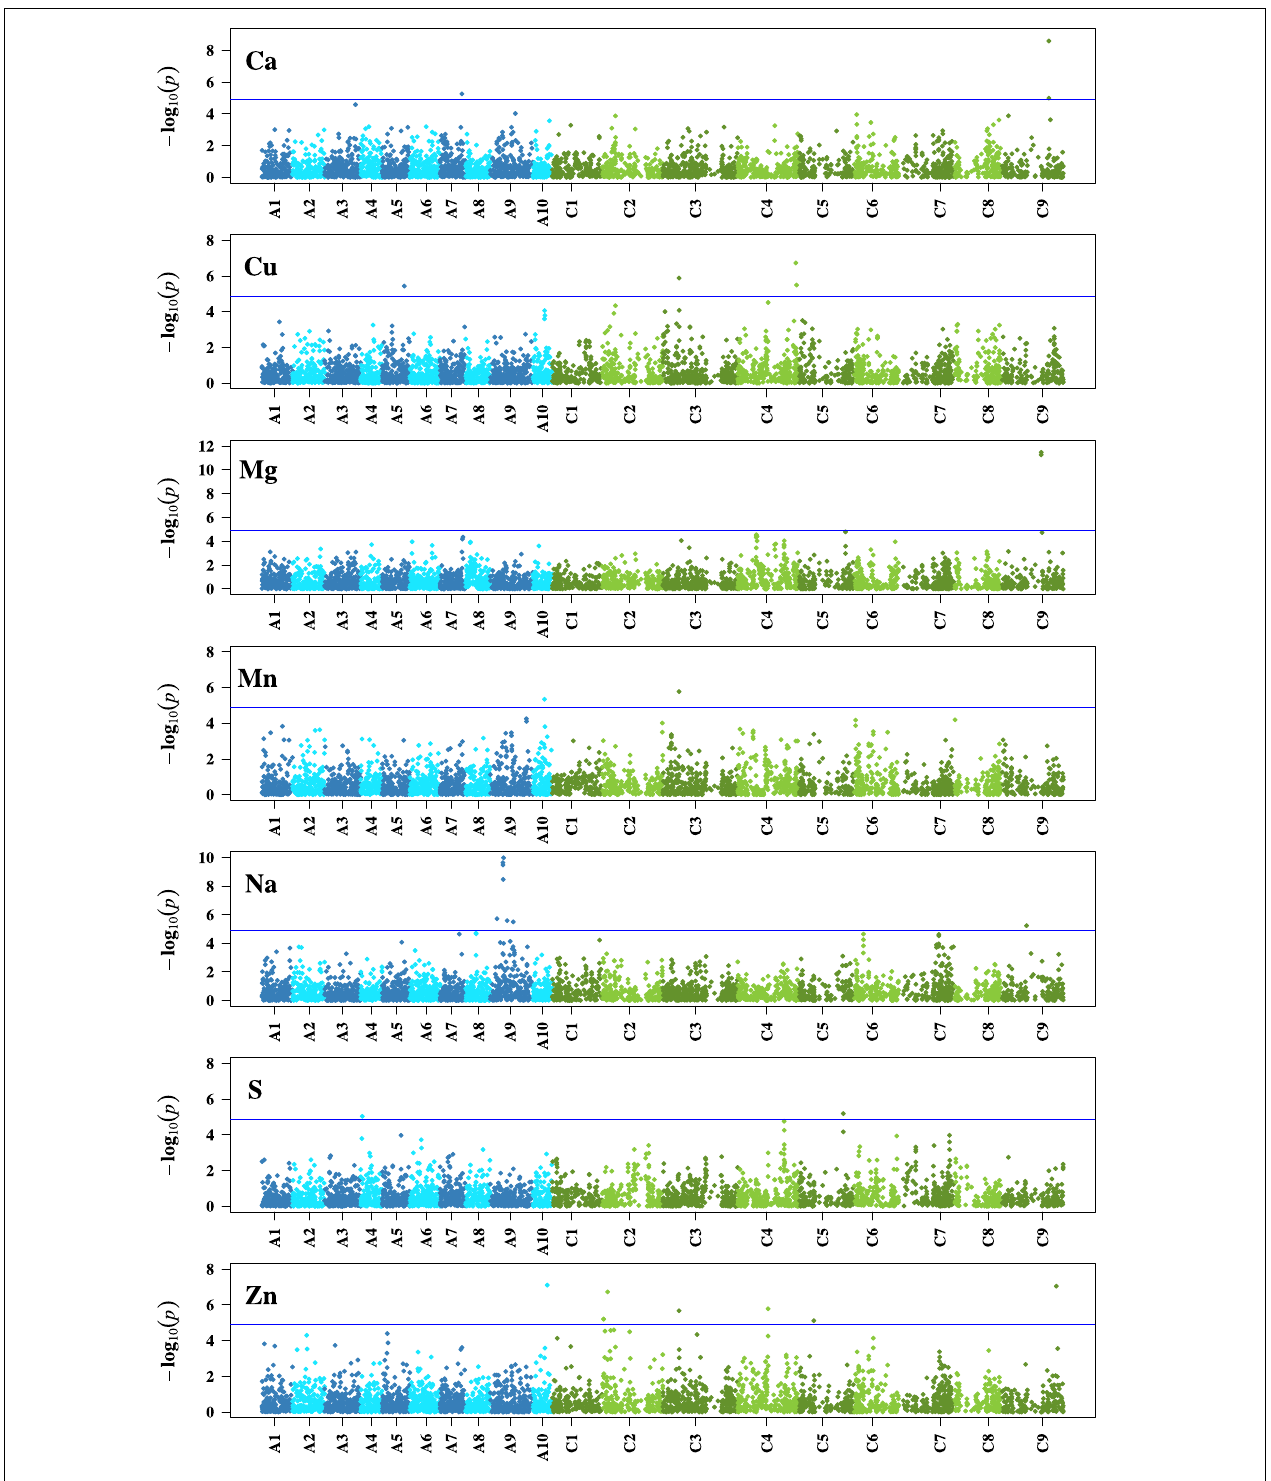
FIGURE 4 | Genome-wide P -values for association analysis of seven mineral concentrations for which significant ( α = 0.05 prior to Bonferroni correction) associations were identified in a B. napus diversity set using a 6K single nucleotide polymorphism array after